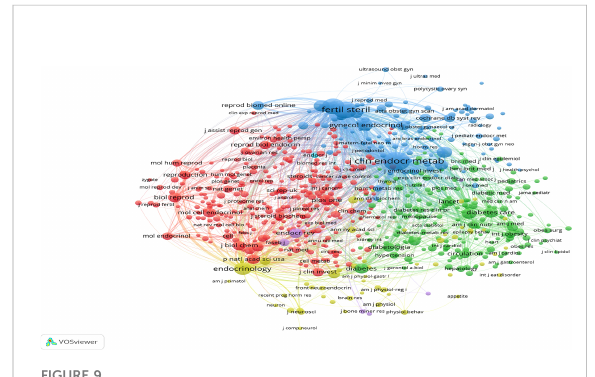
FIGURE 9 The co-citation network visualization map of journals by